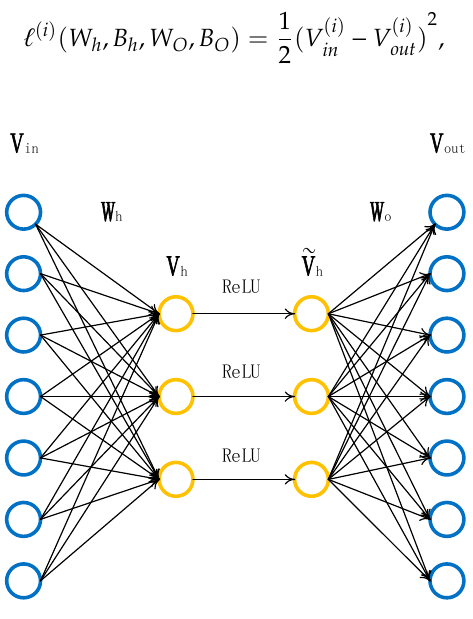
Figure 4. Feature extraction node calculation graph.